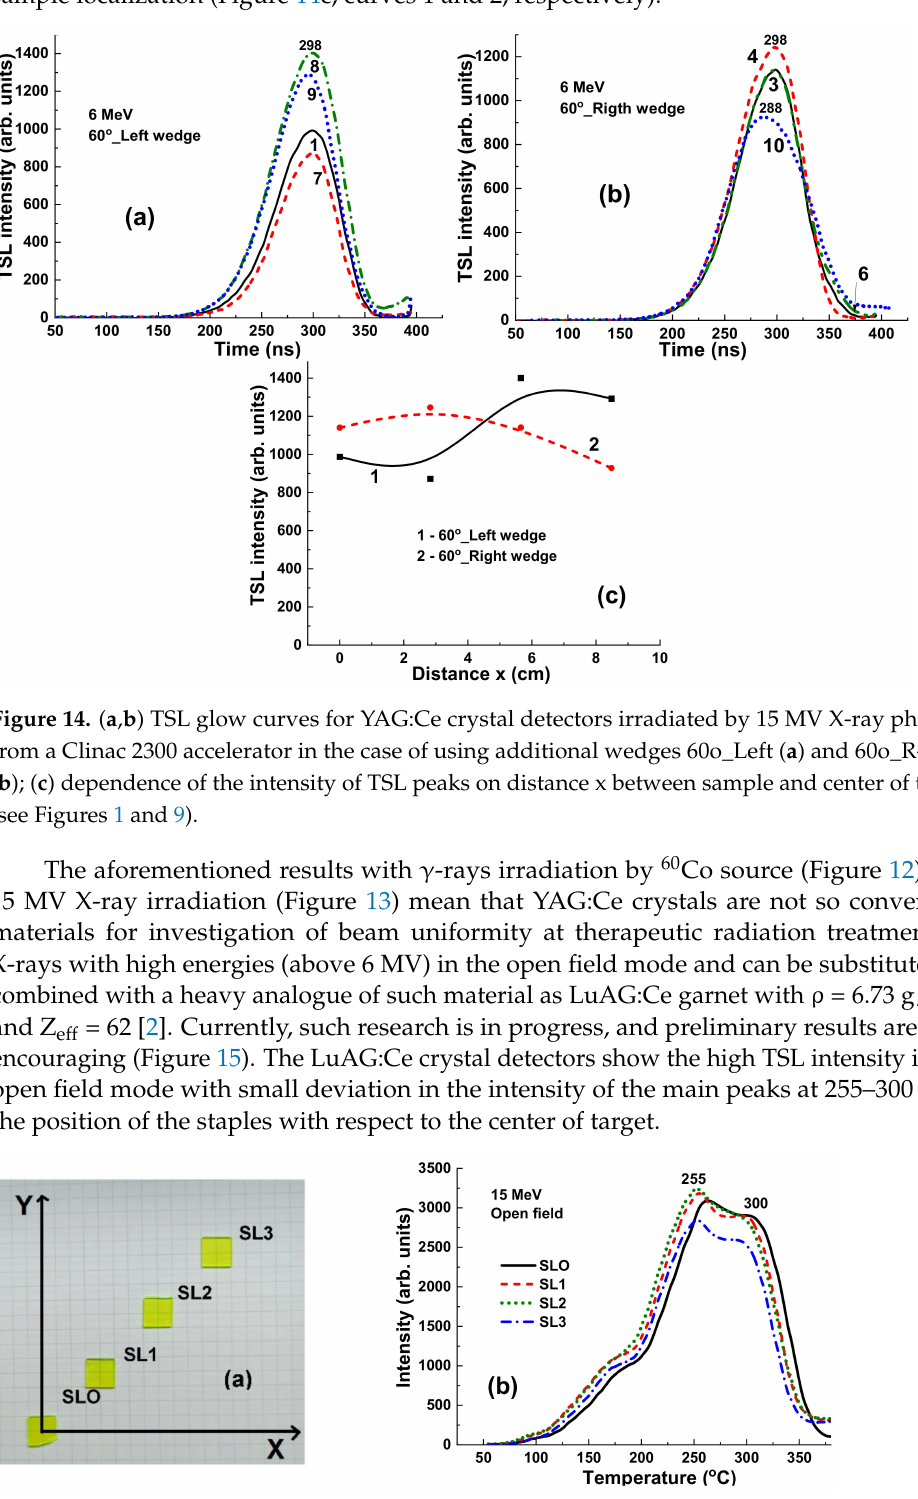
Figure 15. ( a ) Position of LuAG:Ce crystal samples on the experimental x-y plane. ( b ) TSL glow curves for set of LuAG:Ce crystal detectors irradiated by 15 MV X-ray photons from a Clinac 2300 accelerator in the open field